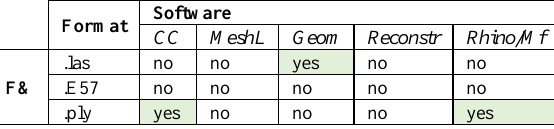
Table 5. Interoperability F6 handheld scanners.